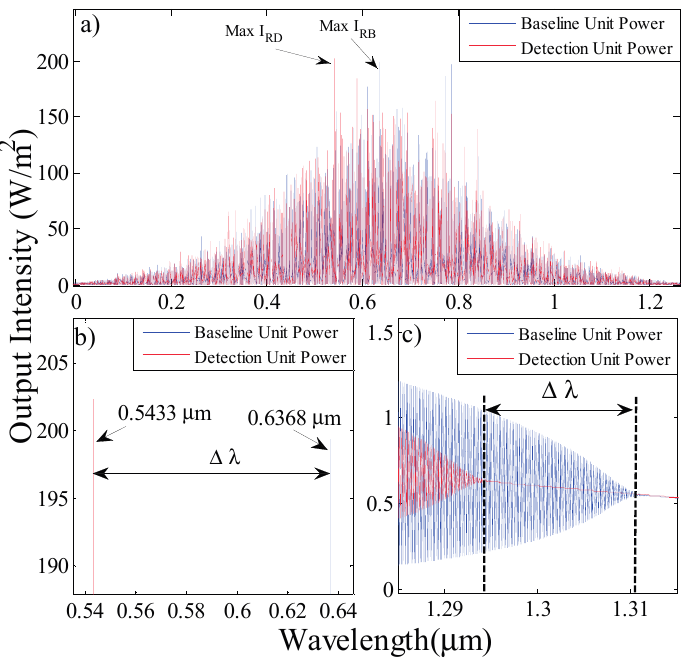
Figure 6. Wavelength shift on baseline cause by the Salmonella bacteria effect on output